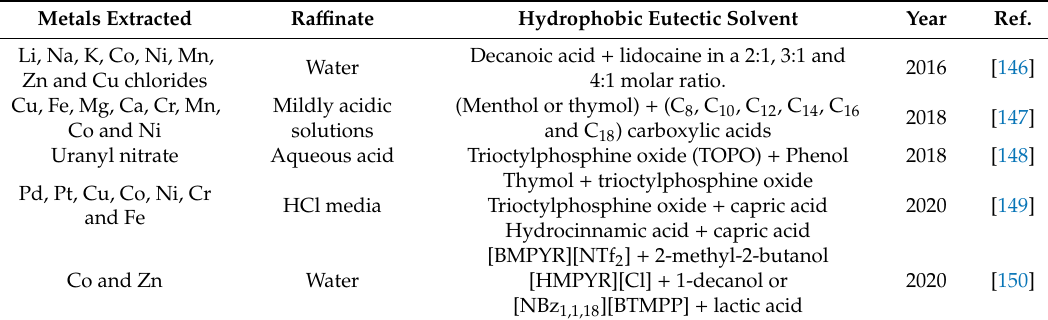
Table 9. Extraction of Metals using Hydrophobic Eutectic Solvents